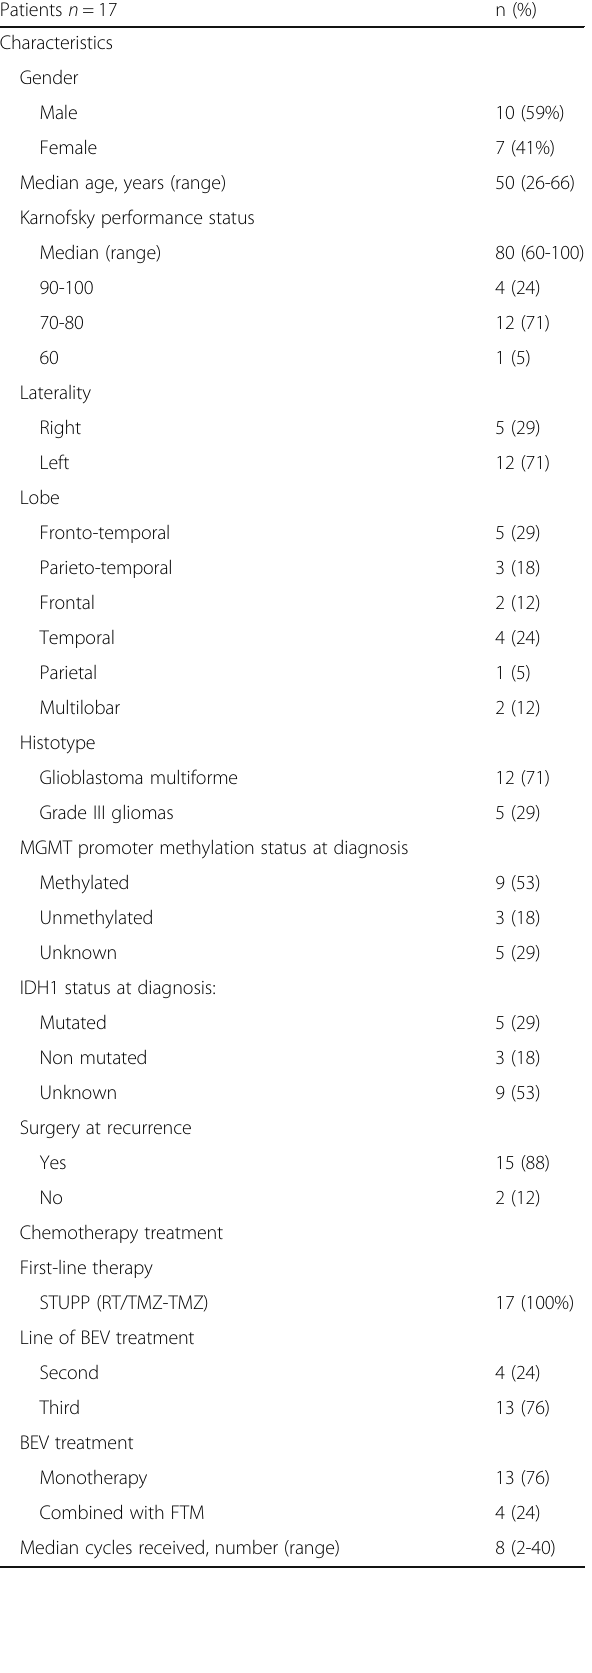
Table 1 Patients ’ characteristics at recurrence Patients n =